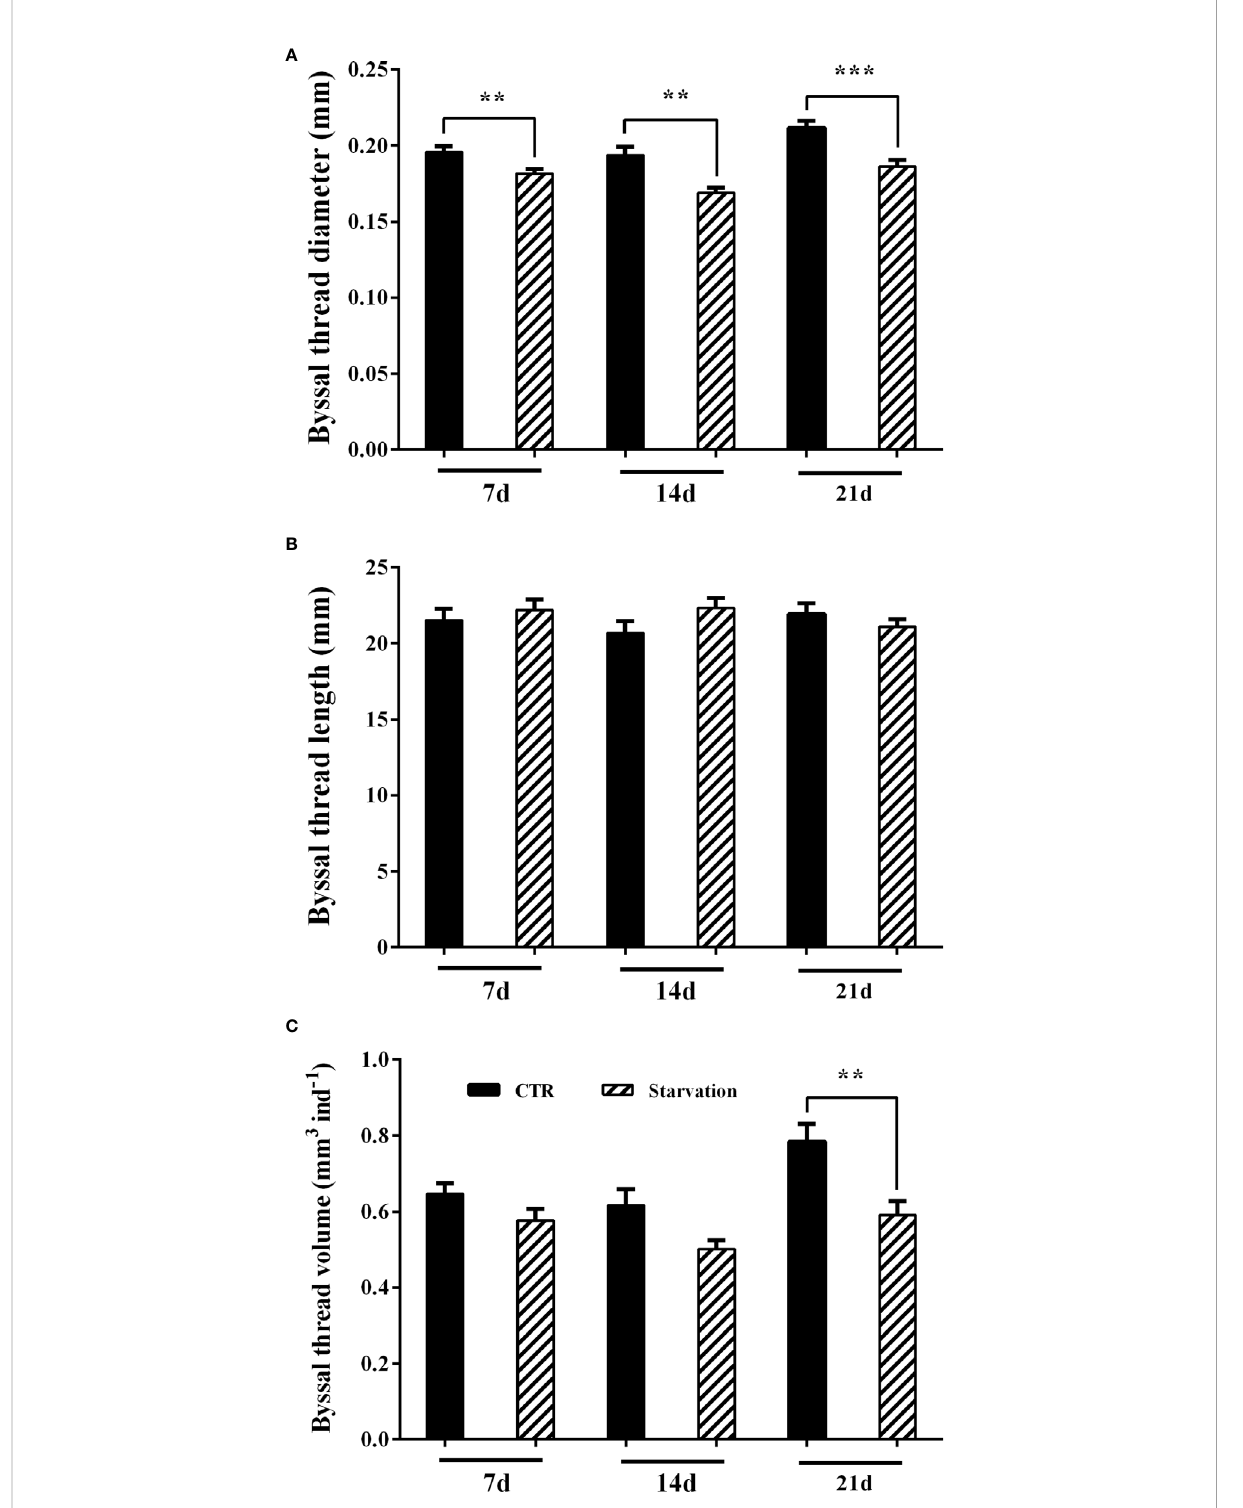
FIGURE 2 Effects of 21 days of starvation on (A) byssal thread diameter, (B) byssal thread length and (C) the cumulative byssal thread volume in M. coruscus . Asterisks indicate signi fi cant differences between starvation groups and CTR groups. ** p < 0.01; *** p <